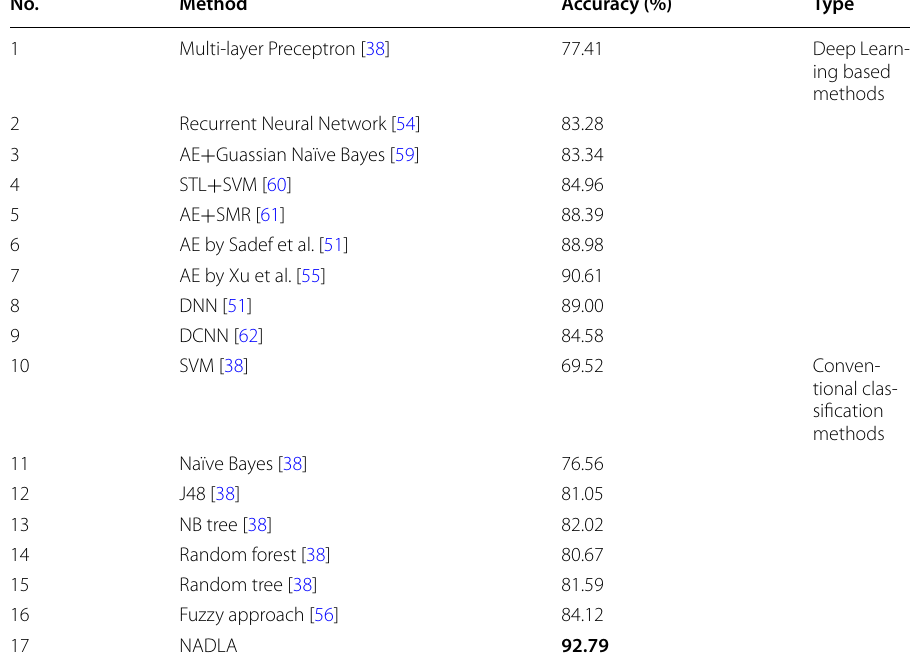
The accuracy of the model we present is marked with bold font